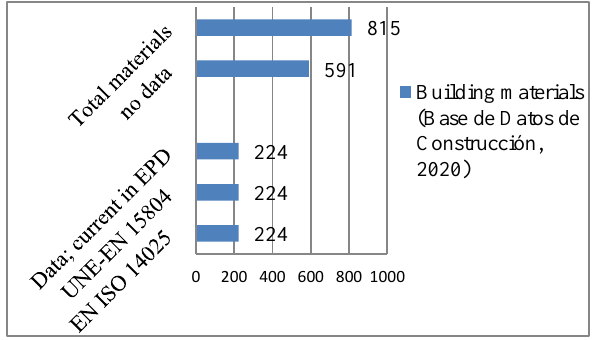
Figure 6. 815 materials were analyzed with 224 compiled CO 2 data (Base de Datos de Construcción,